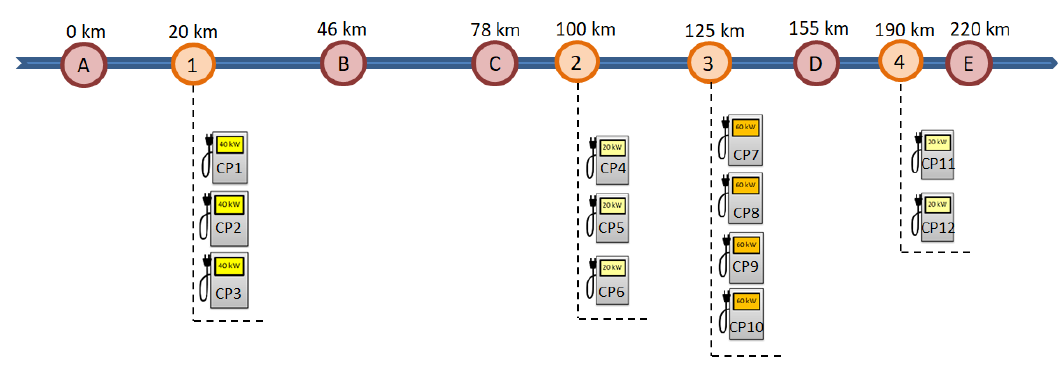
Figure 2. Example of a motorway infrastructure in model I.